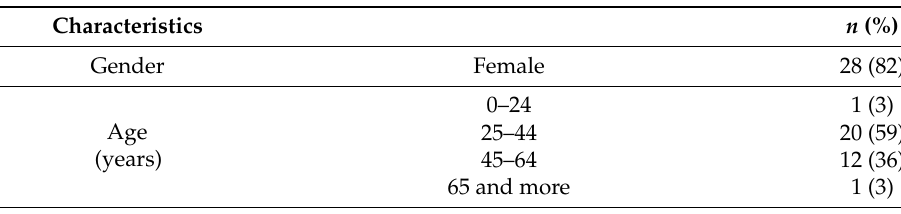
Table 2. Participant characteristics ( n =